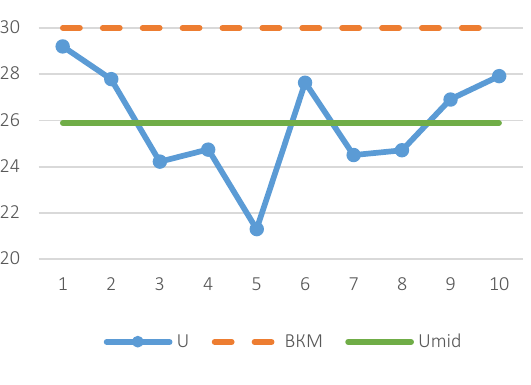
Figure 9. The Shewhart chart for the H10 (high aggregate loans, guarantees and sureties given to insiders) evolution